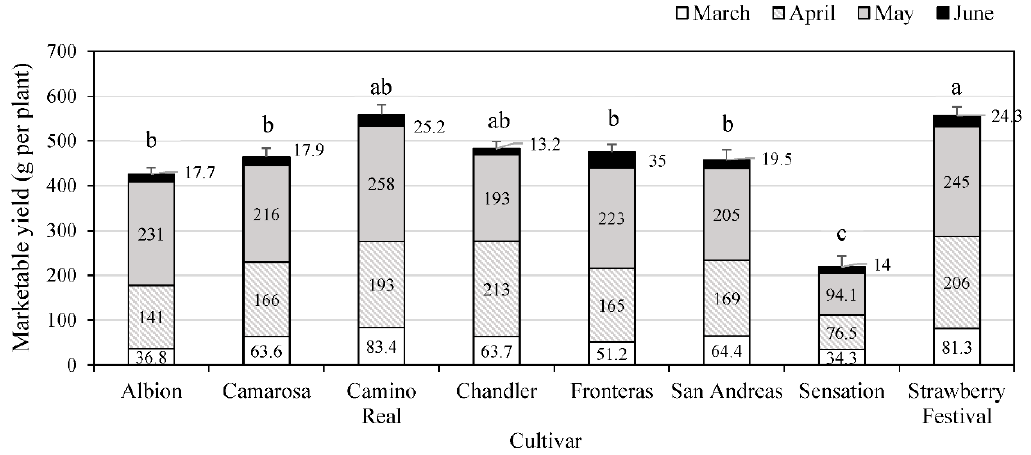
Figure 4. Monthly and total marketable yield of six June-bearing (“Camarosa”, “Camino Real”, “Chandler”, “Fronteras”, “Sensation”, and “Strawberry Festival”) and two day-neutral (“Albion” and “San Andreas”) strawberry cultivars grown with black or red plastic mulches in a high-tunnel production system in Starkville, Mississippi from November 2017 to June 2018. Different lowercase letters on top of each bar indicate a significant difference in total marketable yield among cultivars using Tukey’s HSD test at p ≤ 0.05.